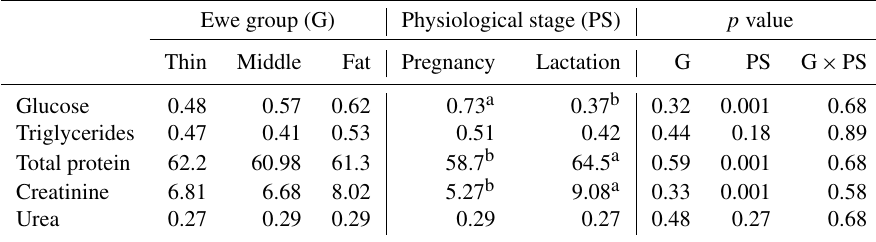
Table 7. Ewe metabolites (mmolL − 1 ) according to lambing body condition score and the physiological stage. Ewe group (G) Physiological stage (PS)